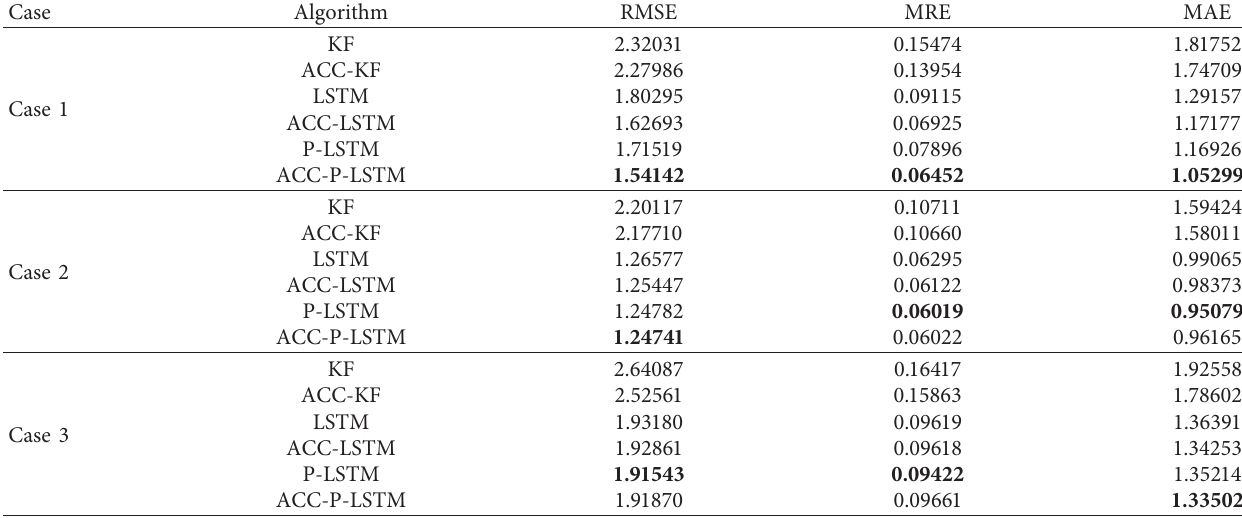
Table 1: Error comparison of different models in three cases (the results with the best performance are highlighted). Case Algorithm RMSE MRE MAE